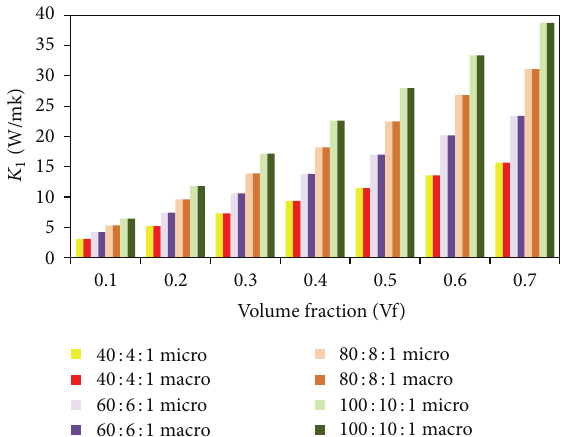
Figure 12: Variation in 𝐾 3 with respect to Vf of hybrid composite for different 𝐾 𝑓1 : 𝐾 𝑓2 : 𝐾 𝑚 .